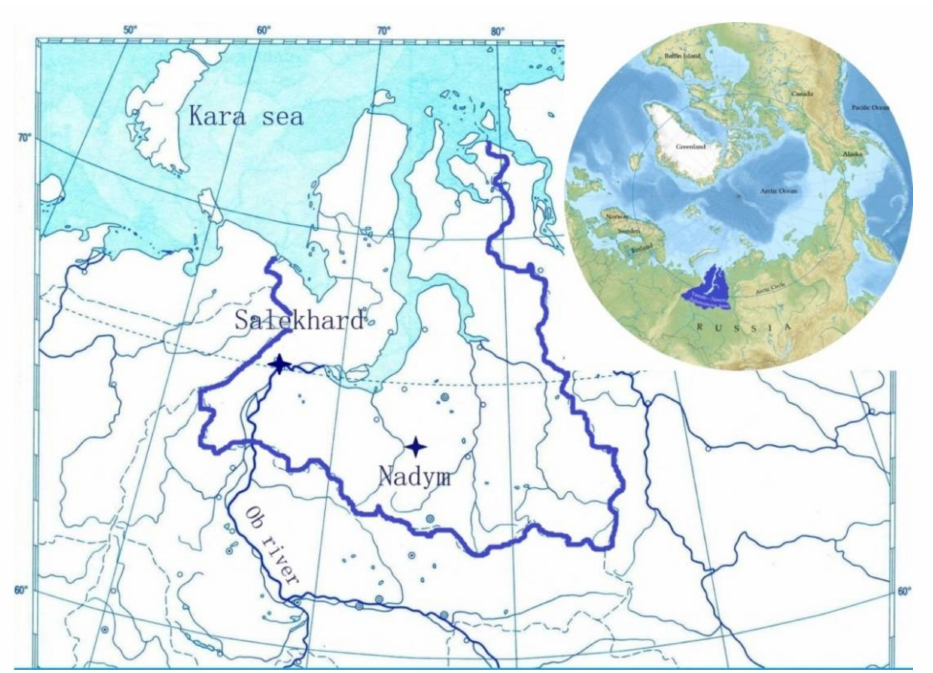
Figure 1. Study area and location of the monitoring stations.